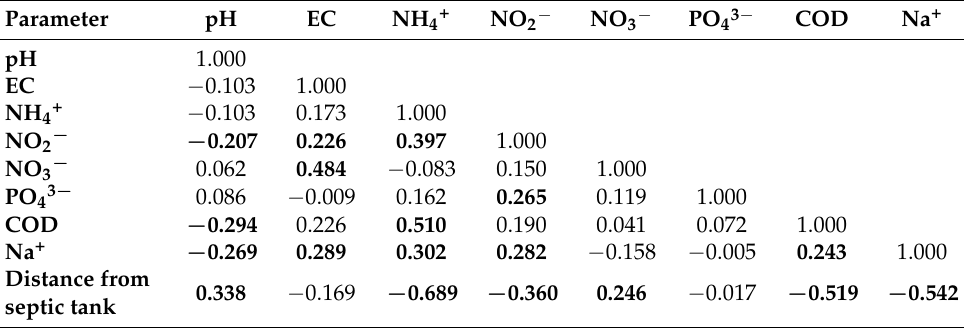
Table 1. Correlation matrix of the investigated parameters.